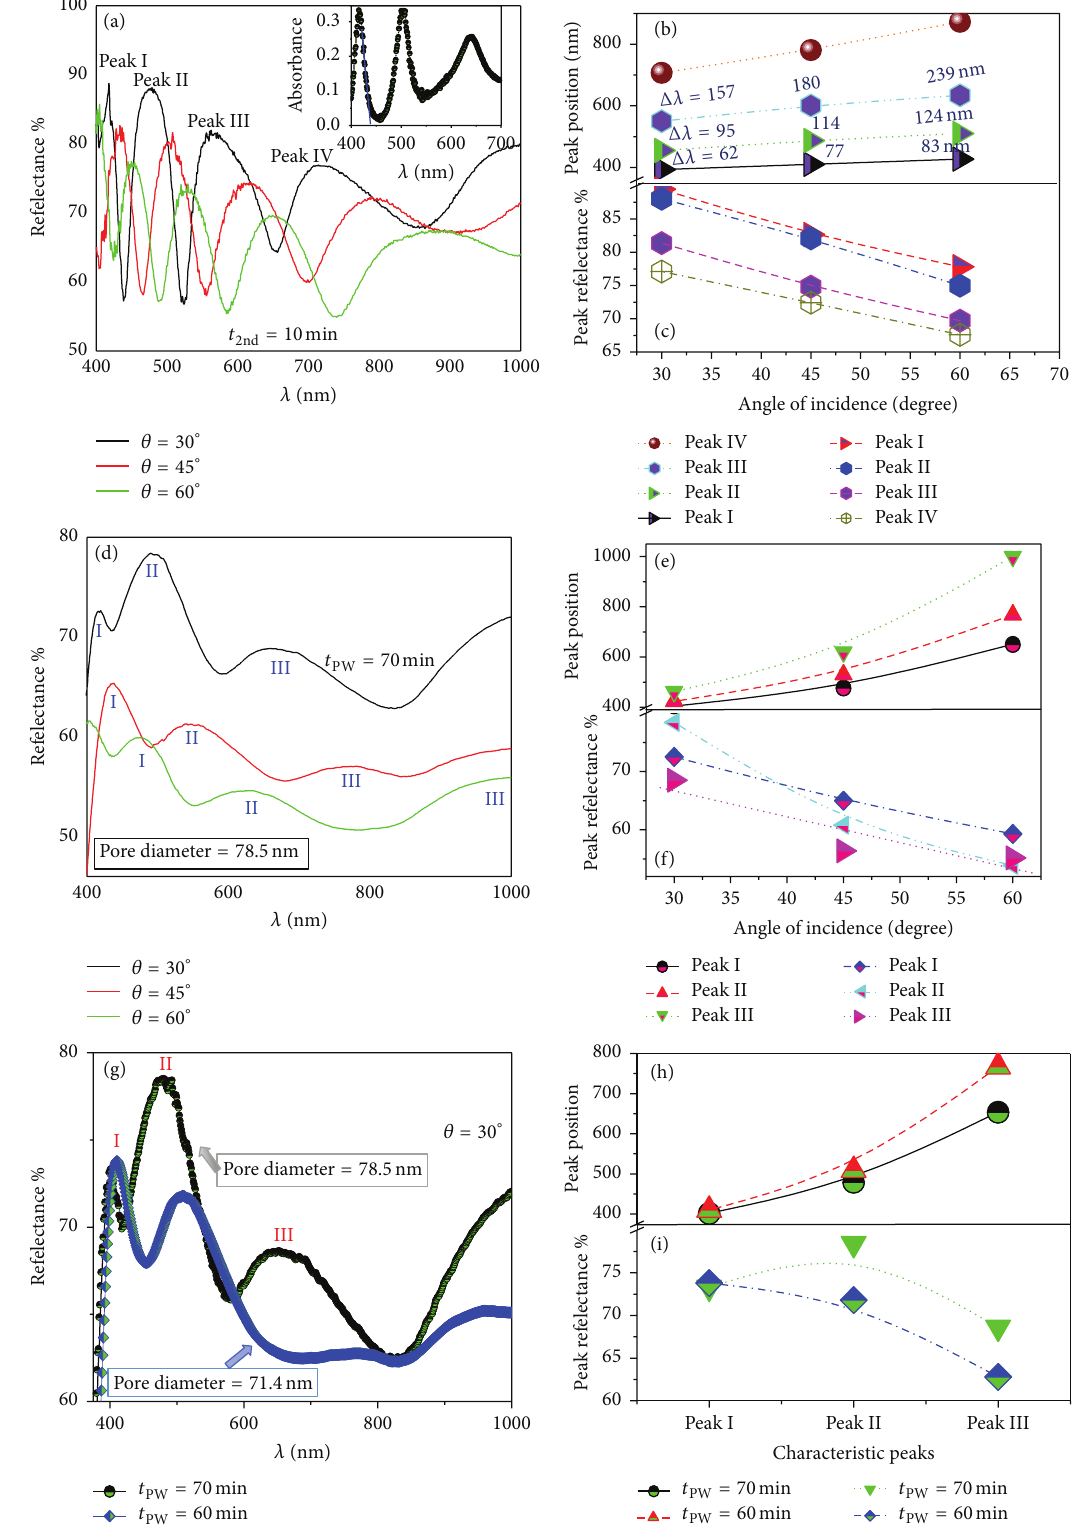
Figure 3: Reflection spectra of PAA membranes (a) as-prepared after 10min second anodization and (d) after posttreatment of 70 min pore widening measured at different angles of incident. The variation of peak position (b, e) and peak reflectance % (c, f) as a function of the angle of incident. The effect of 60 min and 70 min pore widening time on (g) reflection spectra of PAA membrane, (h) peak position, and (i) peak reflectance % at 30 ∘ angle of